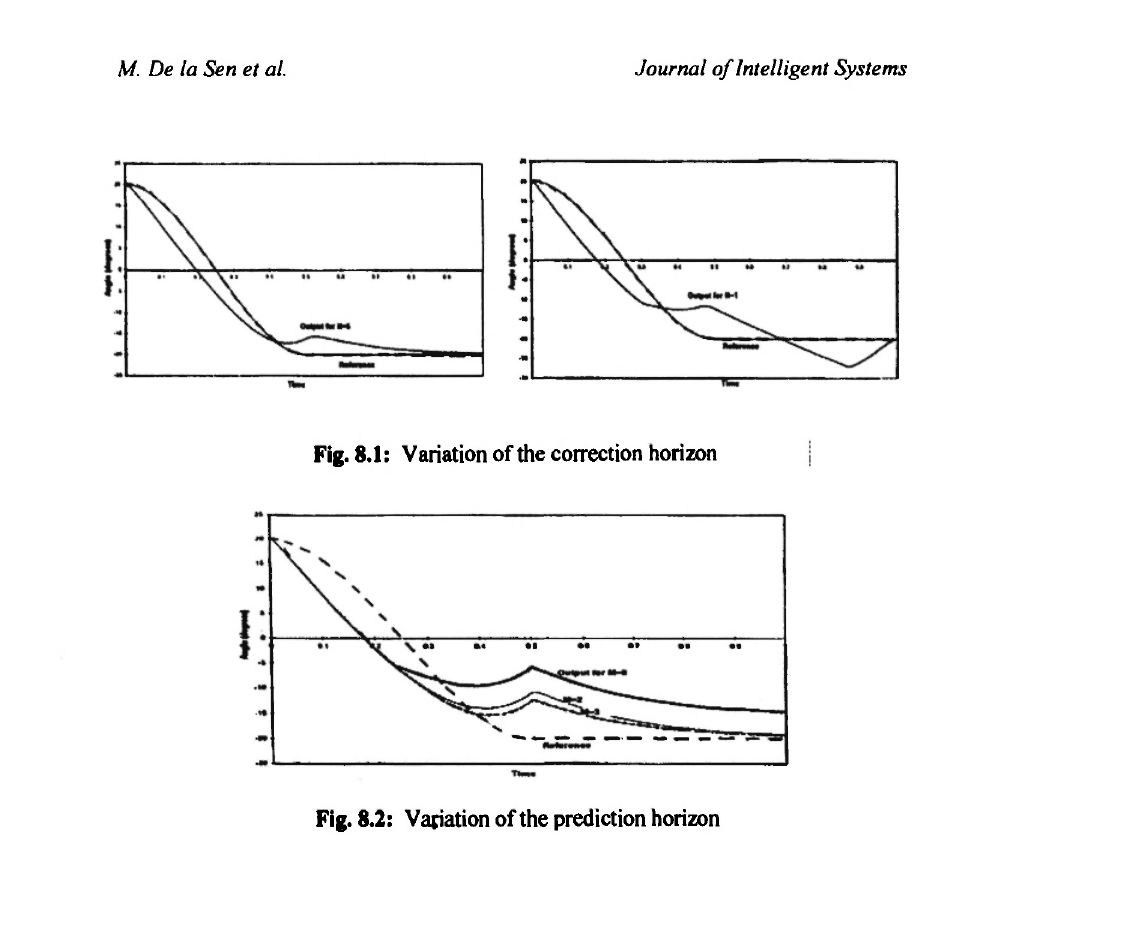
Fig. 8.2: Variation of the prediction